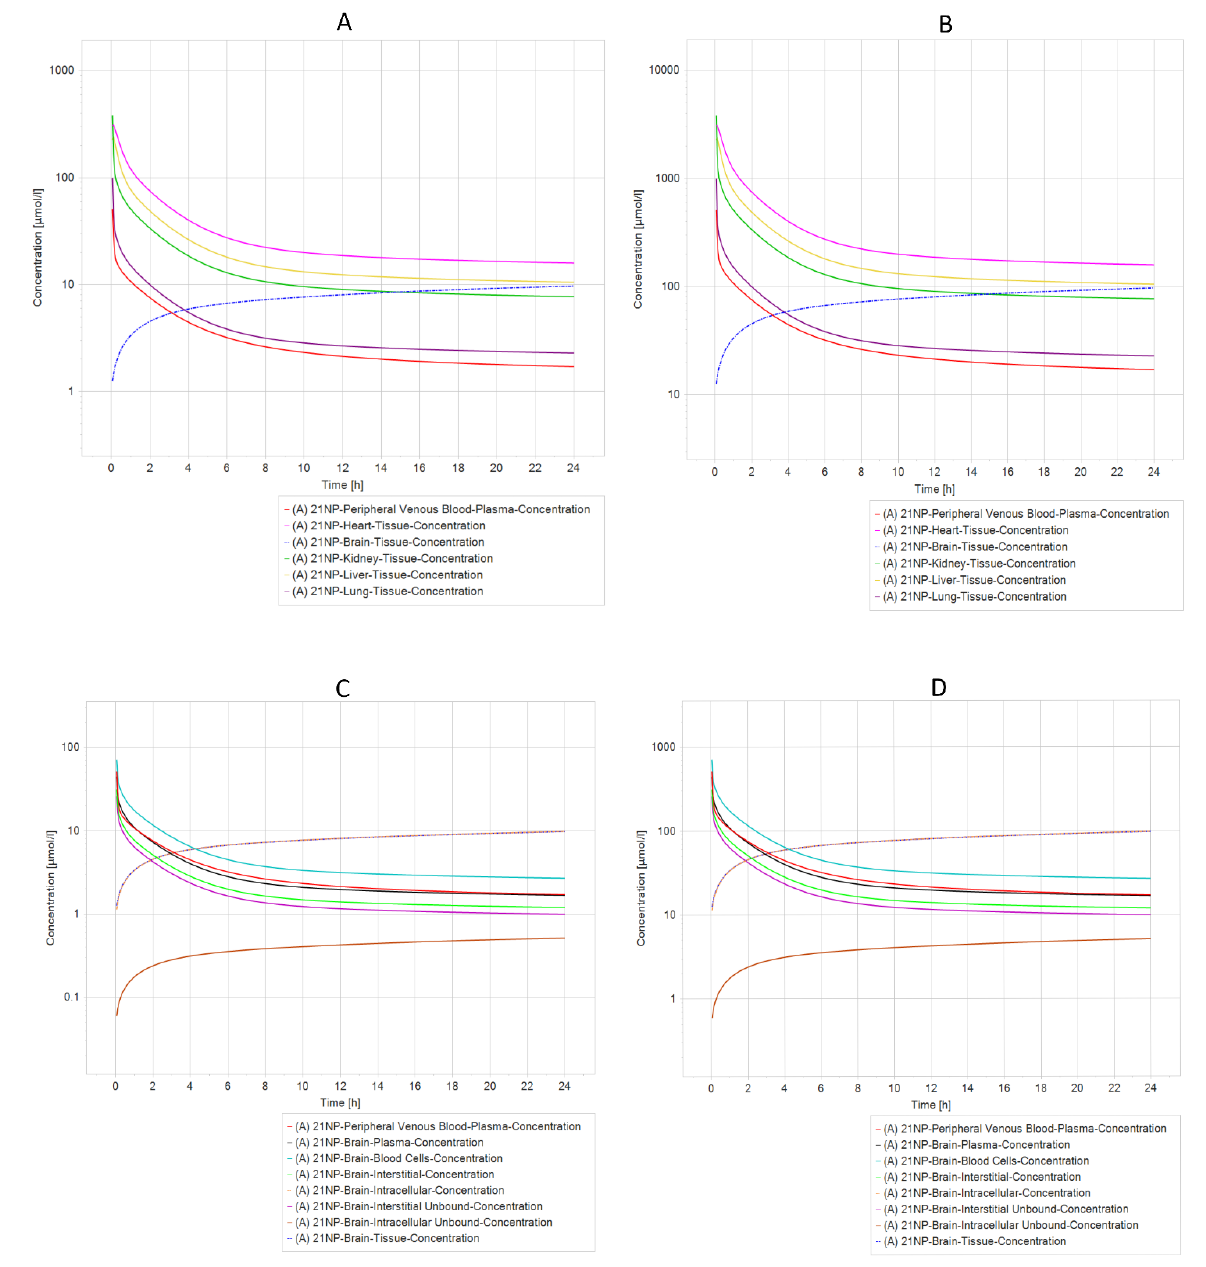
Figure 6. PBPK comparison of different model simulations across different dosages of 21NP molecule modeled in a healthy patient. ( A ) Five different compartments (organs) dosed with 10 mg/kg in a healthy individual. ( B ) Five different compartments (organs) dosed with 100 mg/kg in a healthy individual. ( C ) Different brain compartments dosed with 10 mg/kg in a healthy individual. ( D ) Different brain compartments dosed 100 mg/kg in a healthy individual. The heart, liver, and kidney are the organs with the longest elimination time of molecule 21 NP, whereas in the Brain ( C , D ), there is an increased concentration of molecule 21 NP in tissue and intracellular